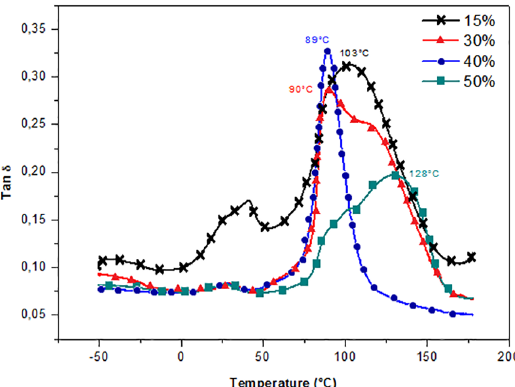
Figure 6. Variation of Tan δ with temperature for reinforced epoxy composites with different volumetric fractions of fique